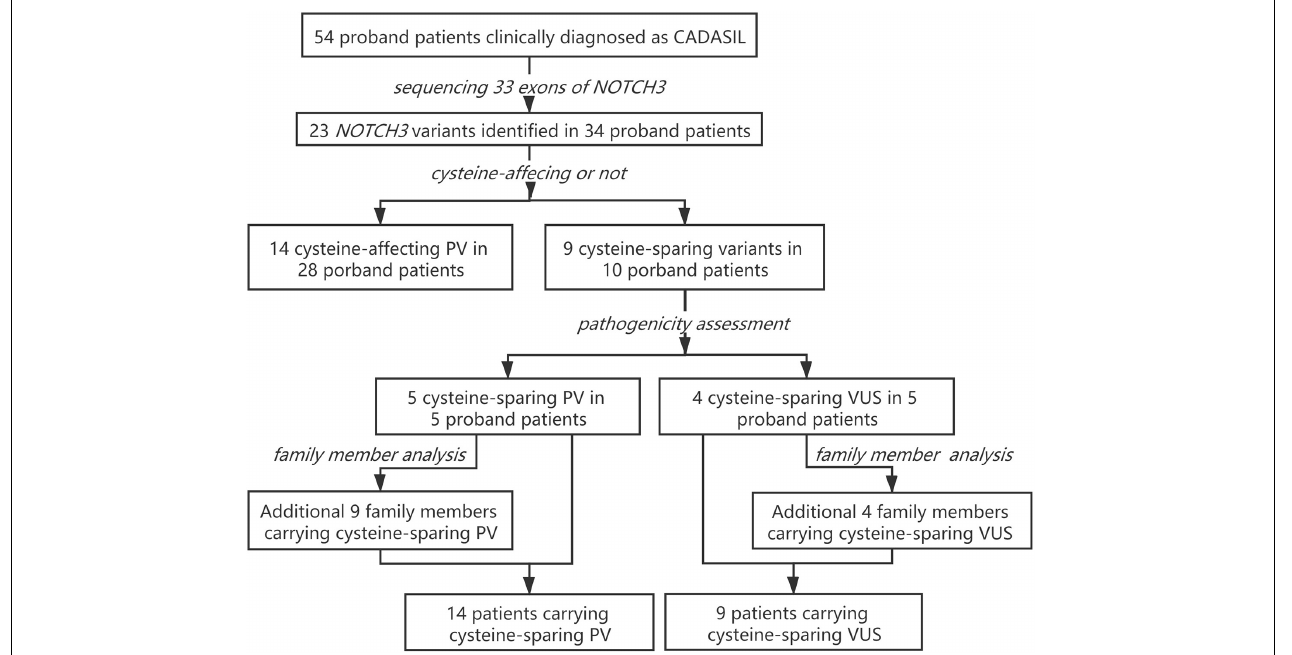
FIGURE 5 | Patient enrollment and study work flow. PV, pathogenic variant; VUS, variant of unknown